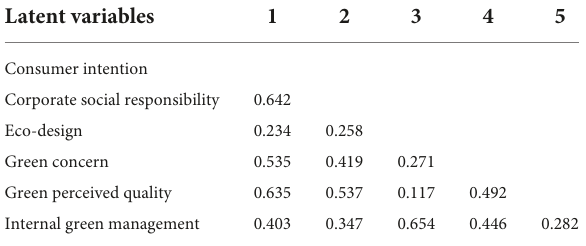
TABLE 5 Heterotrait-to-monotrait (HTMT) ratio results.